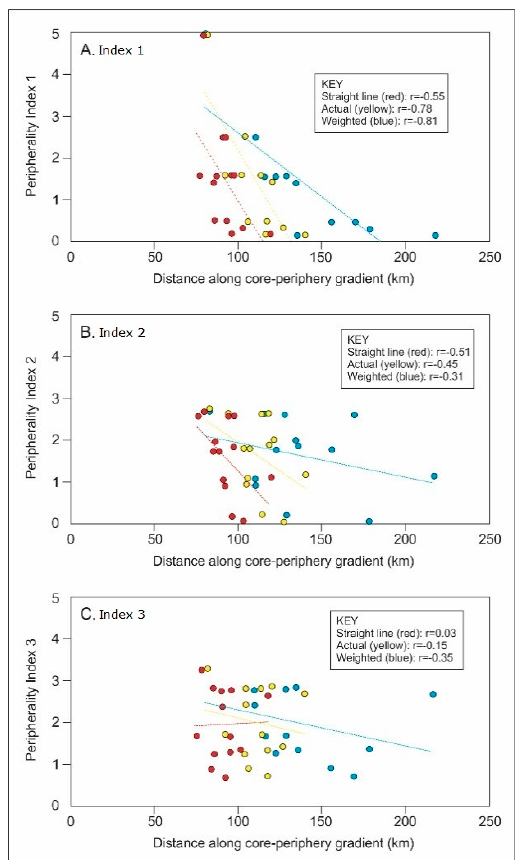
Figure 2. Plots of Indices 1–3 against distances along the core–periphery gradient validate the use of the variables used in their calculation as measures of community